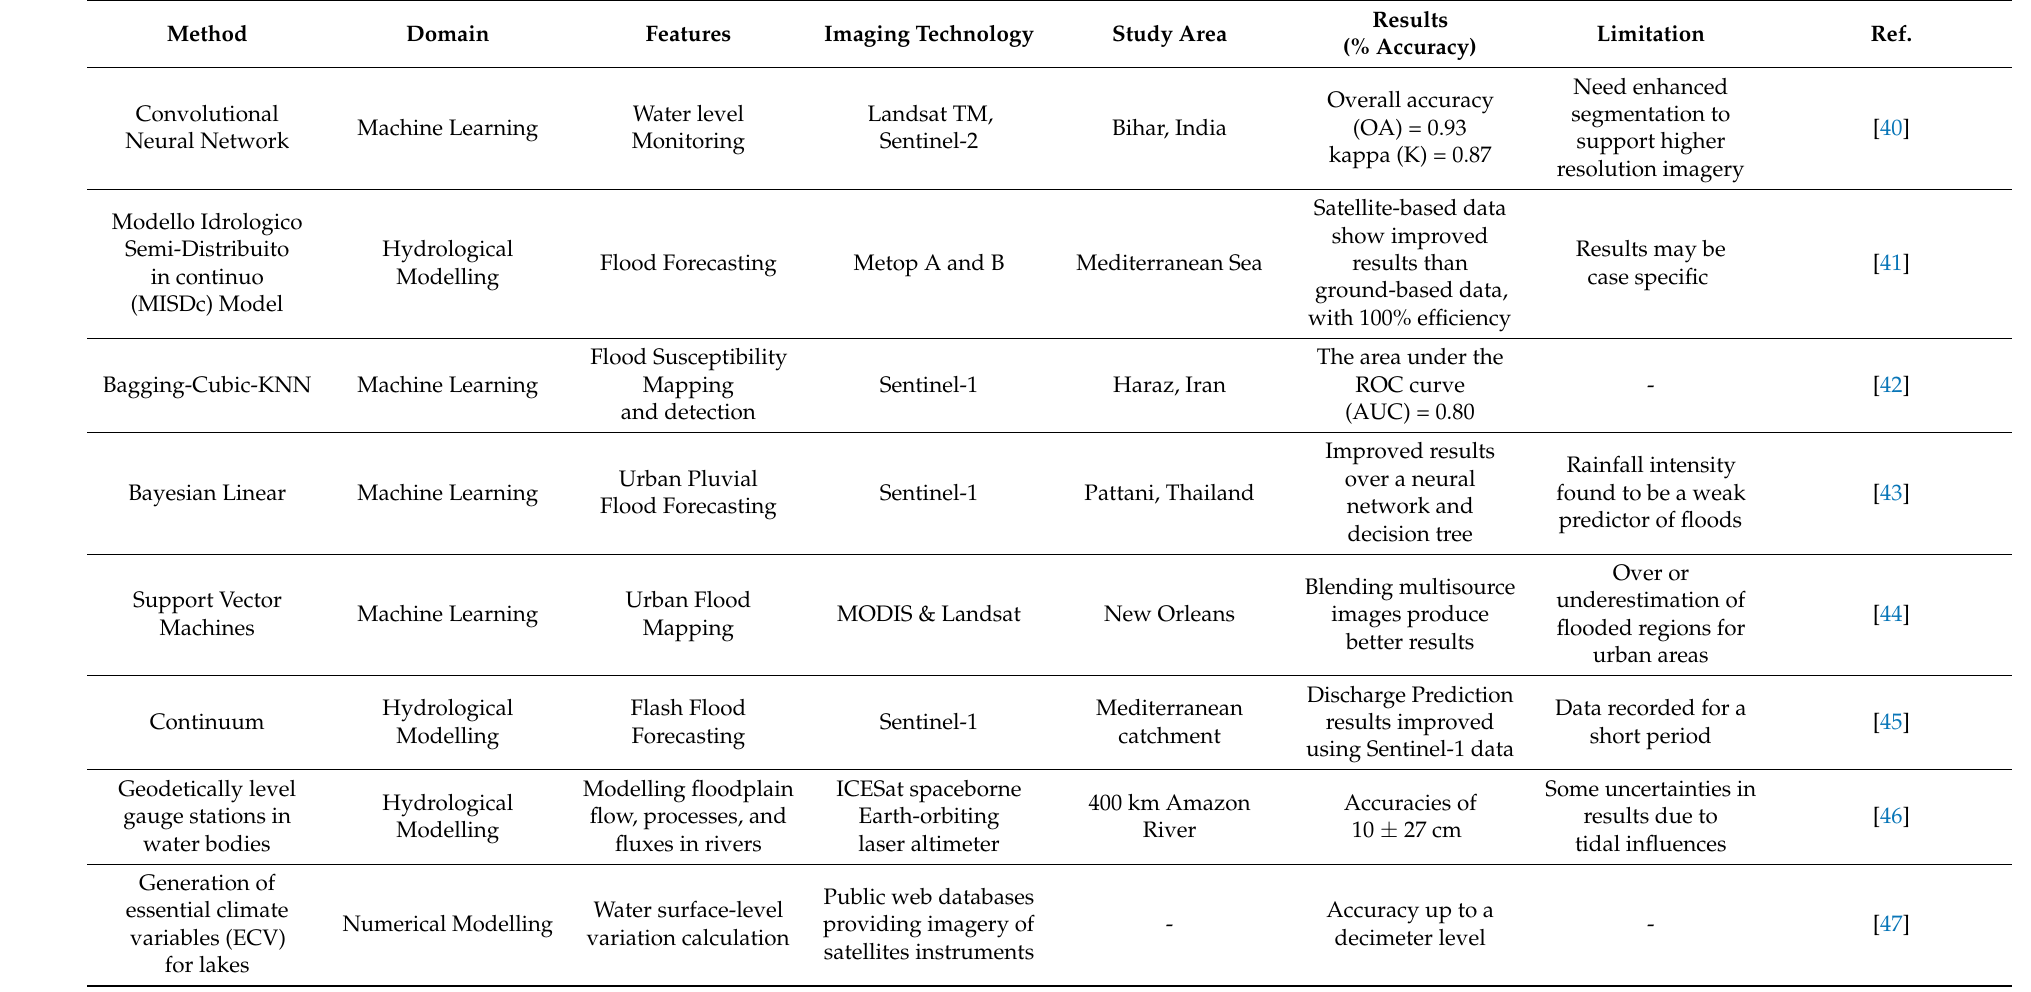
Table 2. Multispectral remote sensing technologies for flood